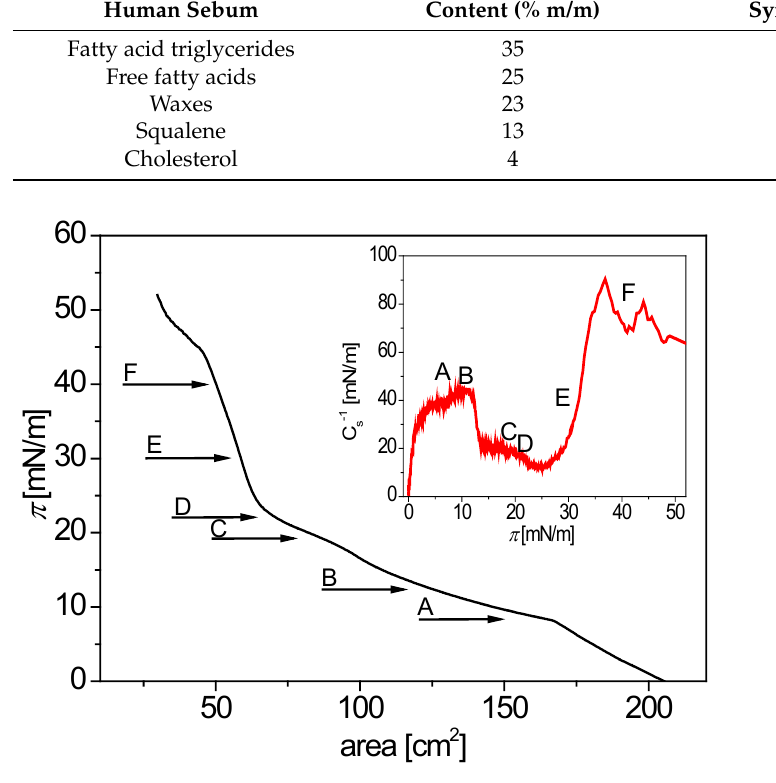
Figure 1. Surface pressure isotherm ( π (A) ) for the synthetic sebum mixture recorded at 21 ◦ C. Arrows and letters indicate the π values where the microphotographs shown in Figure 2 were recorded. The inset shows the compression modulus, C s − 1 , as a function of surface pressure, π .